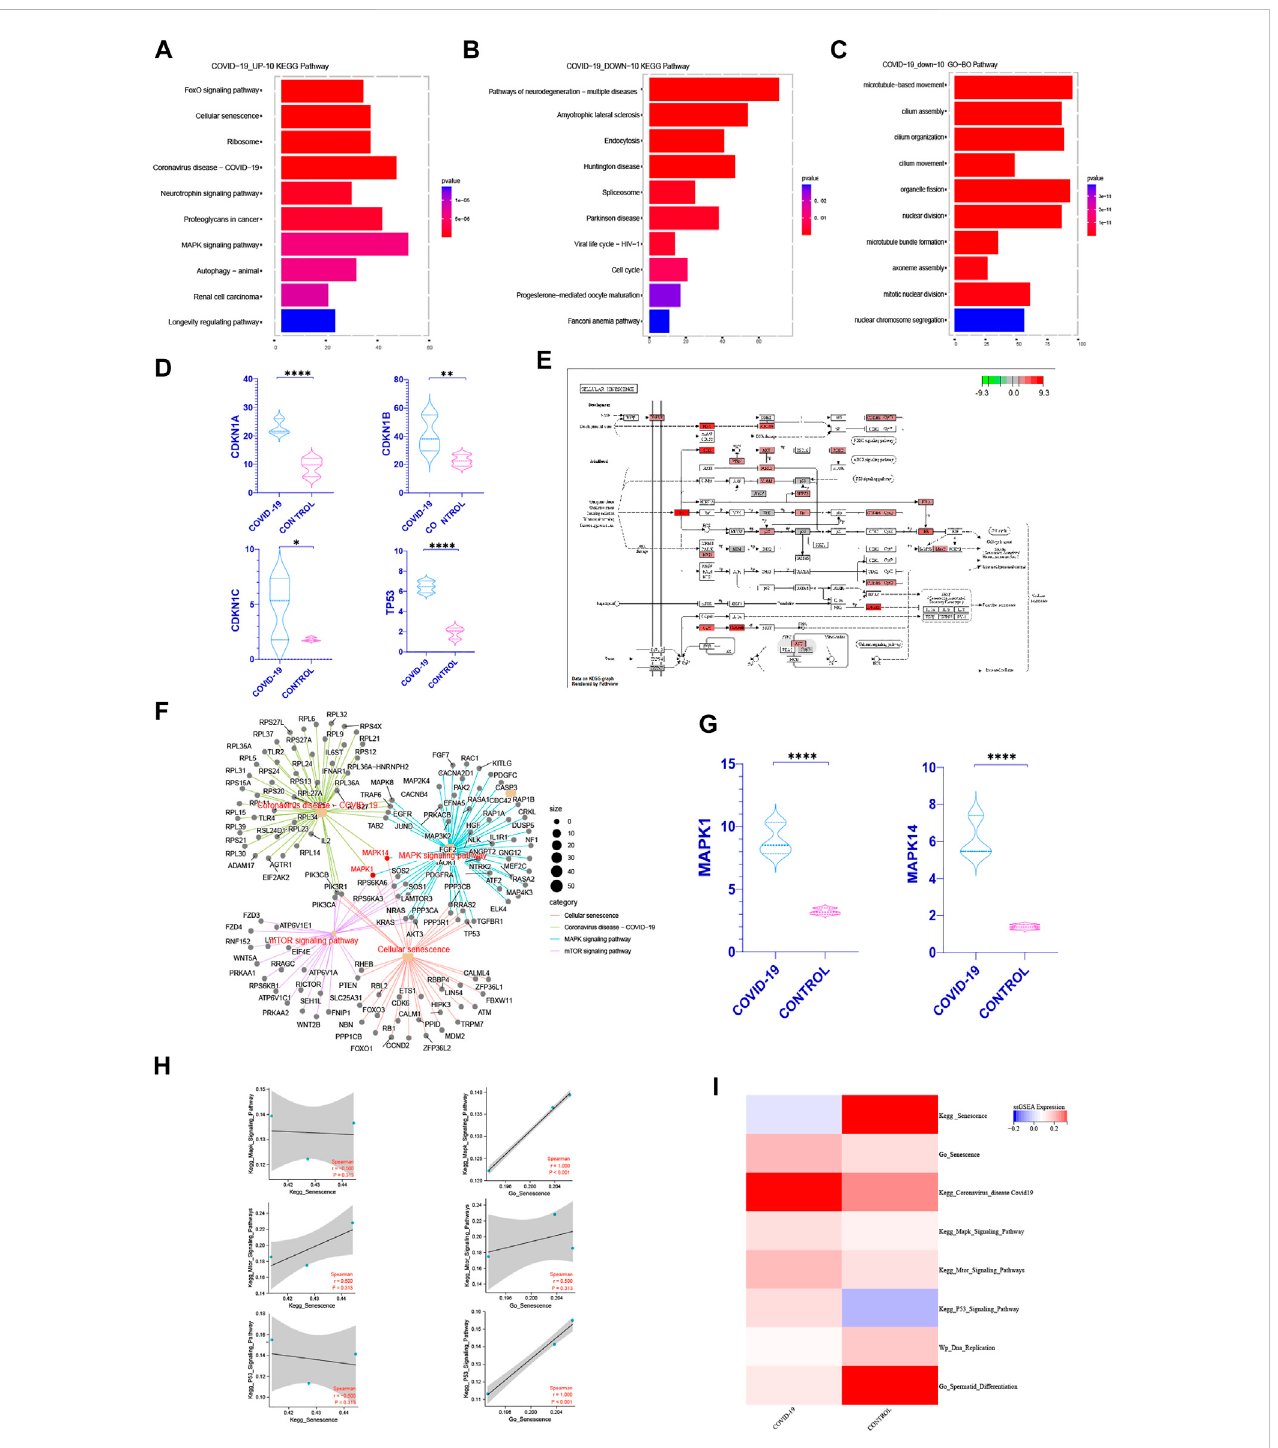
FIGURE 2 COVID-19 inducing senescence in testicular cells after COVID-19 infection. (A) After KEGG enrichment of the signi fi cantly increased genes in patients with COVID-19 infection, the fi rst 10 pathways with the most obvious p -value. Cellular senescence is the most obvious position of p -value (FOXO pathway is one of the internal pathways of cell senescence pathway) (B,C) After KEGG, GO enrichment of genes signi fi cantly decreased in patients with COVID-19 infection,the fi rst10pathwayswiththemostsigni fi cant p -valuewereobtained.Cellcyclerecurredamongthem (D) CellularsenescenceclassicMarkers: CDKN1A, CDKN1B, CDKN1C, TP53 increased in COVID-19 group ( p < .05). (E) The enrichment of enrichment sites in the internal pathway of KEGG — Senescence was detailed, and mTOR, Mapk, and P53signaling pathway were enriched signi fi cantly. (F) Establishing a cross-network between mTOR, Mapk,P53signalingpathwayandCoronavirusdisease-COVID-19,wecanseethatMAPK1,MAPK14playimportantroleasabridge. (G) Thegeneexpressionof MAPK1 and MAPK14 were signi fi cantly increased in COVID-19 group. (H) Correlation between Kegg Senescence Pathway and GO Senescence Pathway and otherrelatedpathwaysthatinhibitcellcycle.GOSenescencePathwayismorepositivelycorrelatedwiththem. (I) ssGSEAscoreofKeggSenescencePathway, GOSenescencePathway,spermdifferentiation,DNAreplicationandothercellcycleinhibitionpathways.ssGSEAscoreofGOSenescencePathwayandother cell cycle inhibition pathways